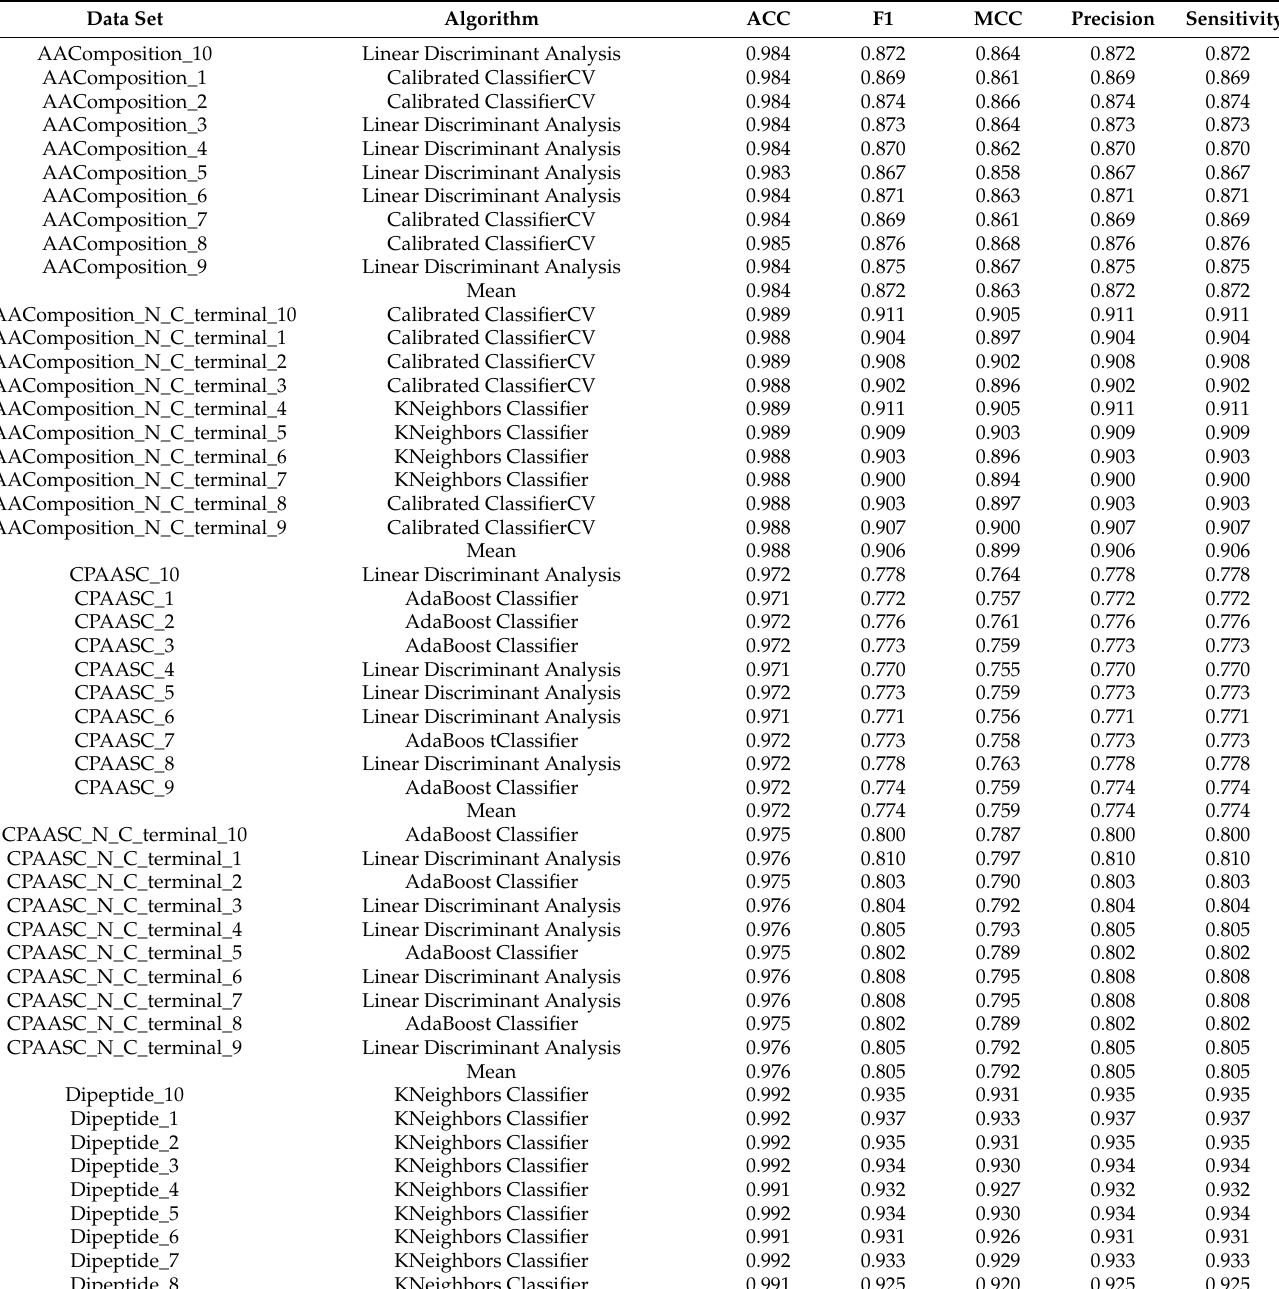
Table 5. Summarized results of the evaluation models built with the RLP subfamily